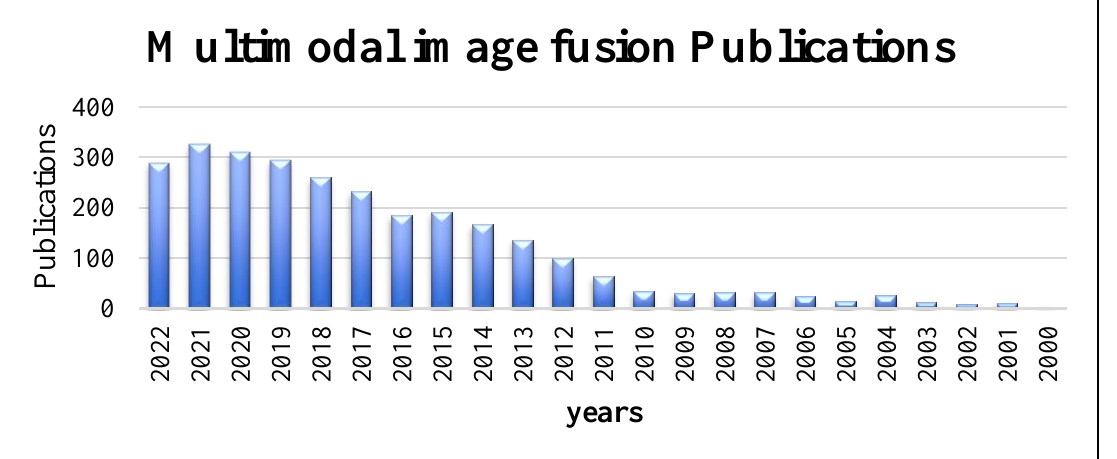
Figure 1. Multimodal image fusion publications per year obtained from PubMed (2000 to third- quarter year, 2022).